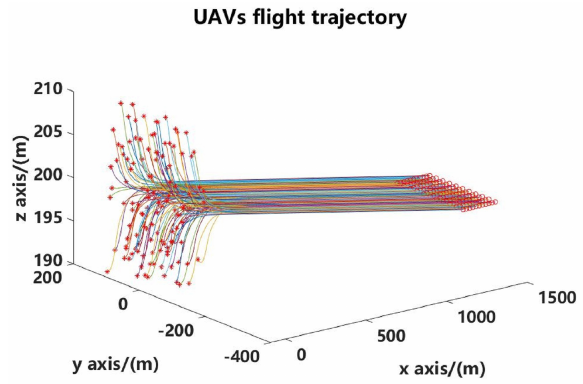
Figure 18. 121 UAVs’ flight